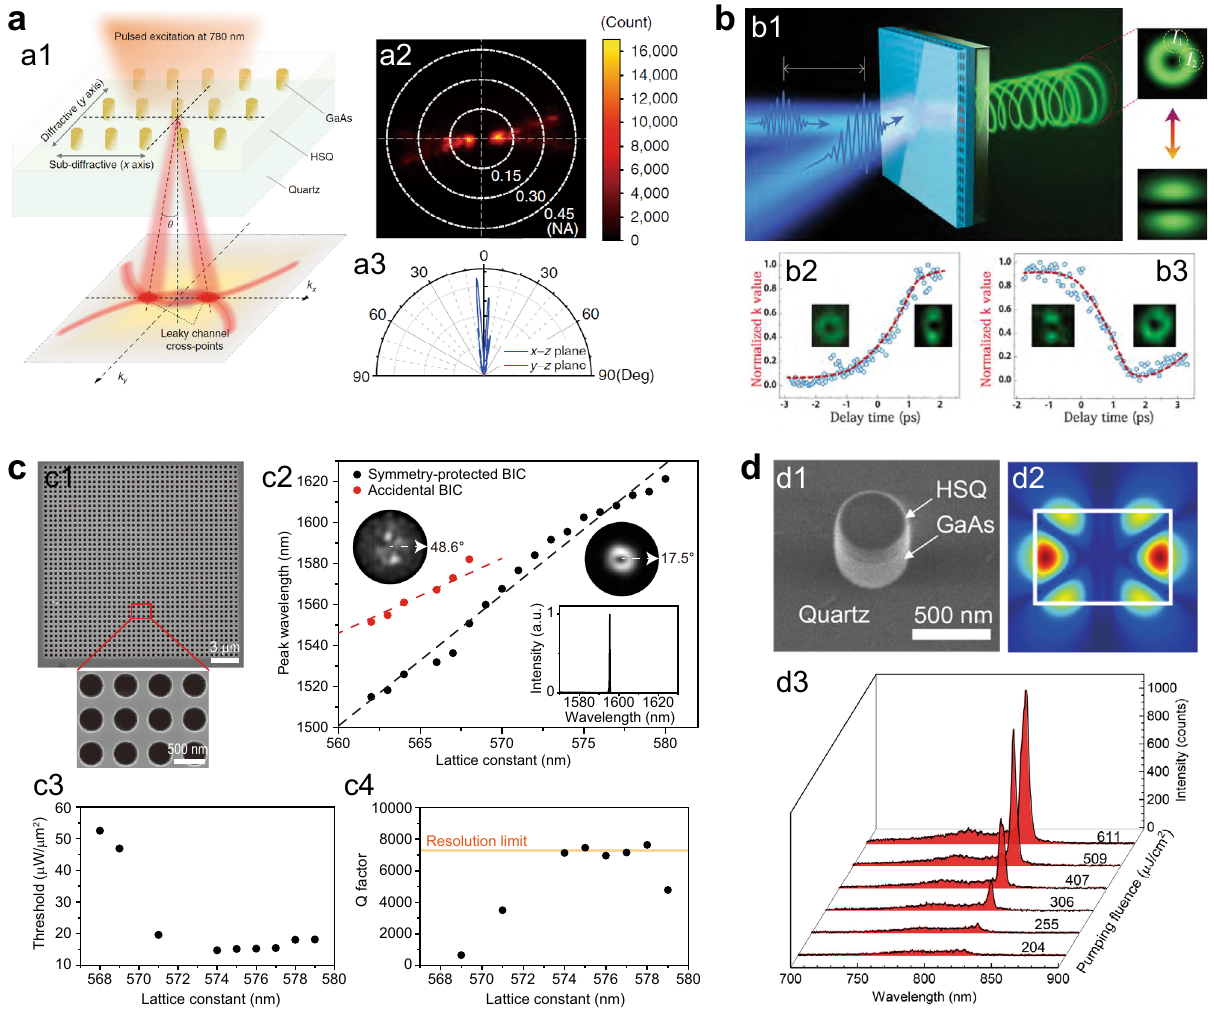
Fig. 7 Lasing from BICs. a Directional lasing in nanoantenna arrays. Schematic of a GaAs nanopillar array on a fused silica substrate embedded in hydrogen silsesquioxane (HSQ) resist (a1). Measured back-focal plane image (a2) and directivity (a3) of the emission above the lasing threshold. Reprinted by permission from ref. 19 , copyright 2018. b Ultrafast control of vortex beam. Schematic of a two-beam pumping experiment and the measured far- fi eld emission patterns under both symmetric and asymmetric excitations (b1). Transition from a BIC microlaser to a linearly polarized laser (b2) and the reverse process (b3). Reprinted by permission from ref. 23 , copyright 2020. c Ultralow-threshold super-BIC laser. Scanning electron microscope (SEM) images of a fabricated laser structure consisting of 40 × 40 unit cells (c1). Measured lasing wavelengths and far- fi eld images of symmetry-protected BIC lasers (black dots; right inset) and accidental BIC lasers (red dots; left inset) as a function of the lattice constant (c2). The bottom inset shows the above-threshold spectrum of a super-BIC laser. Measured threshold values divided by the pump area (c3) and Q factors estimated by the peak wavelength and the linewidth at the transparent pumping condition (c4), as a function of the lattice constant. The orange line indicates the Q factor obtained using the resolution-limited linewidth of the spectrometer. Reprinted by permission from ref. 25 , copyright 2021. d Lasing from single nanoparticles. SEM image (d1) and simulated near fi eld of a quasi-BIC (d2) in a single GaAs nanocylinder. Evolution of the emission spectrum of the resonator at different pumping fl uence values (d3). Reprinted by permission from ref. 24 , copyright